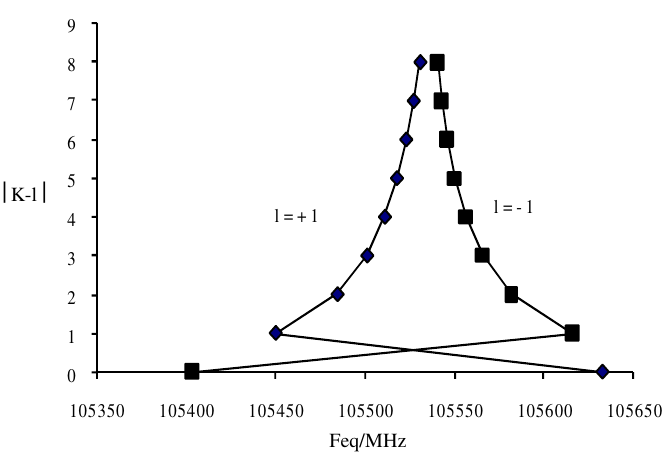
Figure 7. Fortrat diagram for (CH